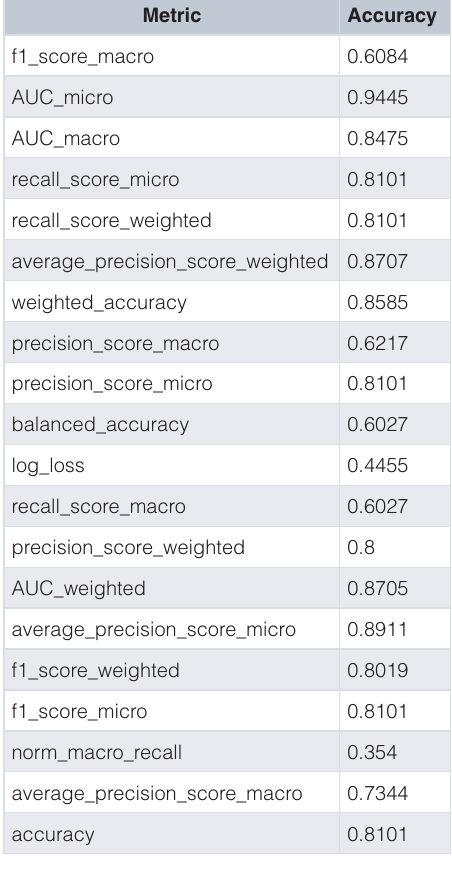
Table 11. Model metrics of the final clearance rate ensemble